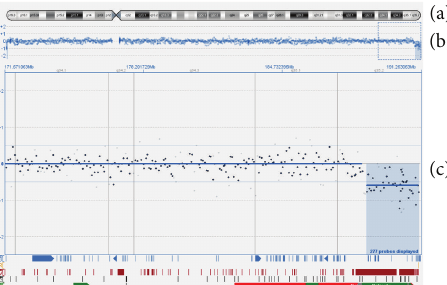
Figure 5: Array-CGH result of chromosome 4: 4q35.2 → qter deletion. There are three icons from top to down in total (a)– (c). (a) A diagram of chromosome 4. (b) A scatter plot of a copy number; each point represents the mean copy number calculated fromconsecutive100probesets.Thebaselineinthemiddleindicates the normal copy number level. Upward deviation from the baseline indicates amplification and downward departure from the baseline represents deletion. (c) Enlarged form of 4q35.2 → qter segment at (b) region; combed region represents copy number variants (CNV) that matches deleted